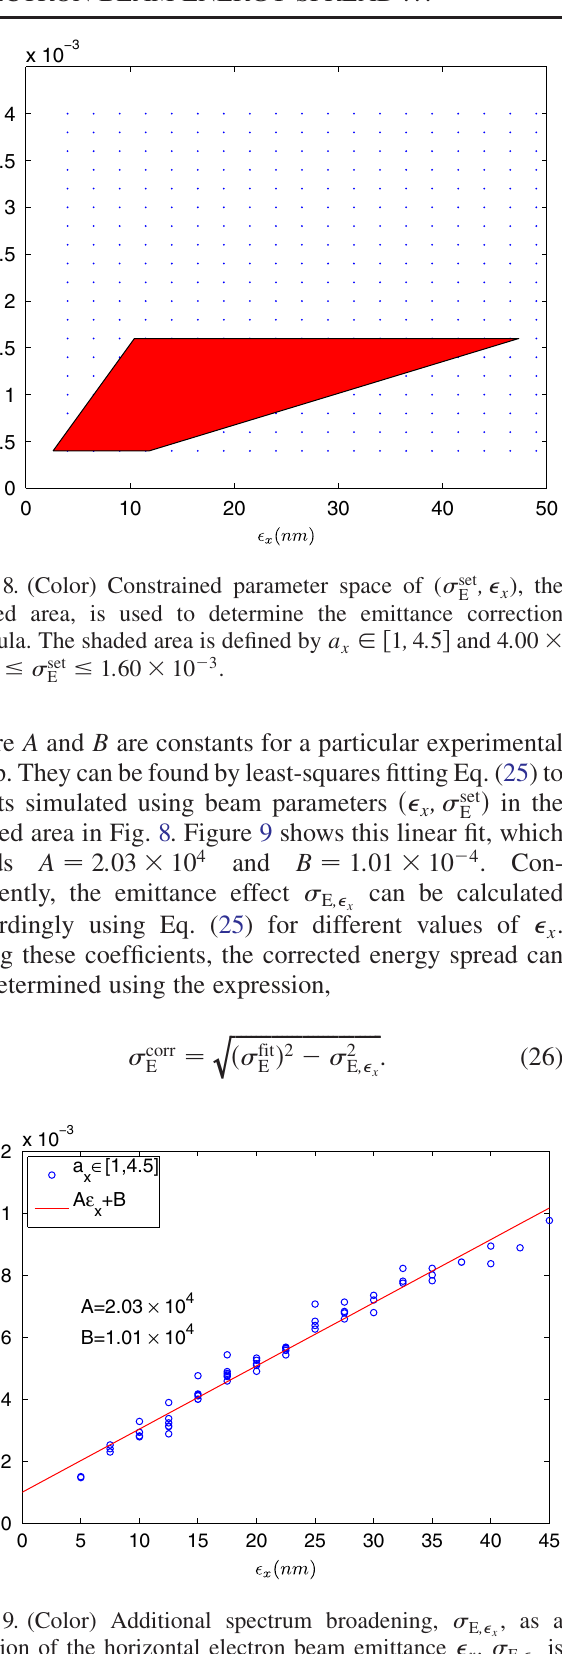
and the fitted parameters are listed in x